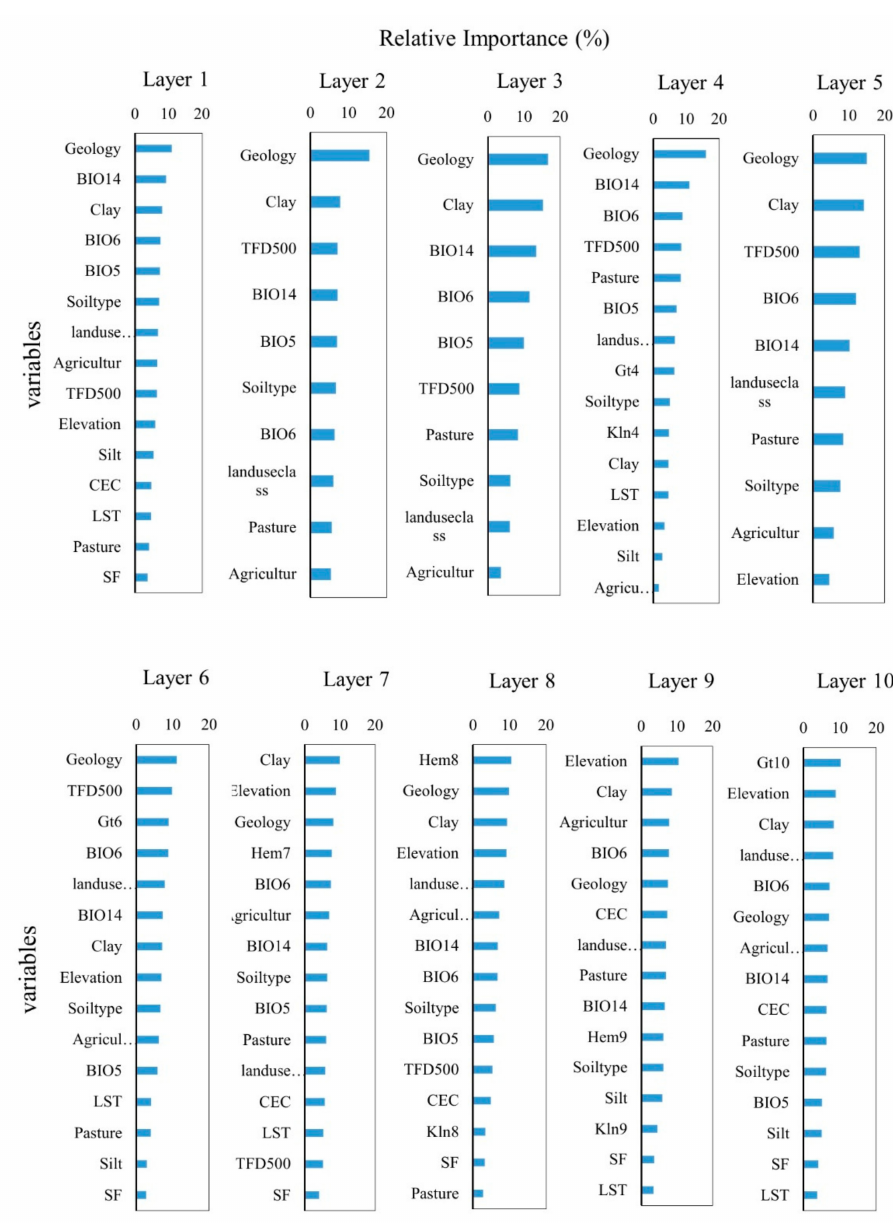
Figure 10. Variable importance for SOC stocks prediction in different depth for total samples by